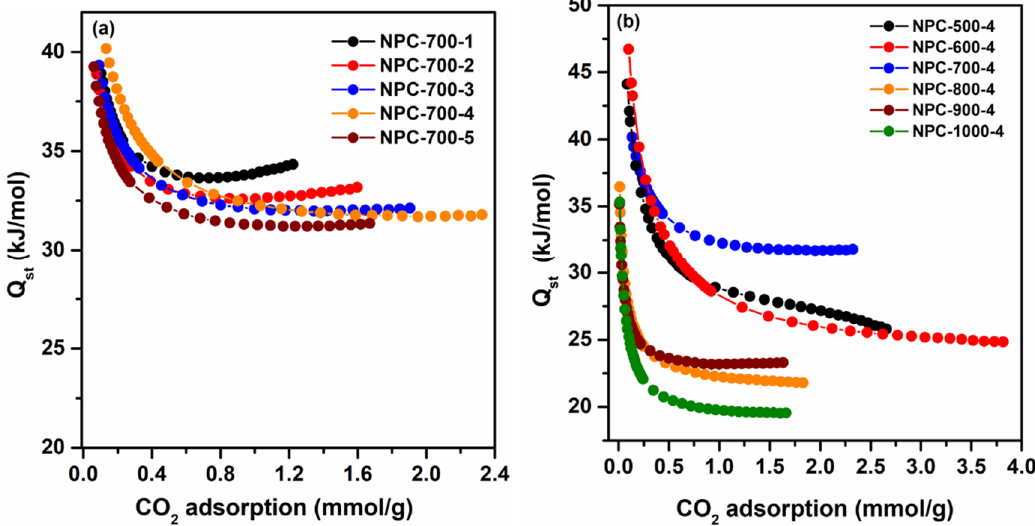
Figure 9. Isosteric heat of CO 2 adsorption as a function of CO 2 uptake for NPC-700-x ( a ) and NPC-y-4 ( b ).